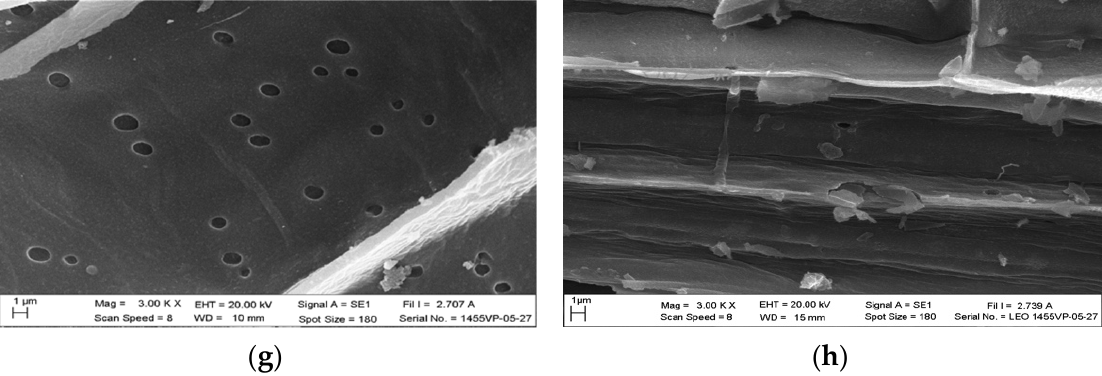
Figure 6. SEM morphologies acquired with a 3000 magnification of ( a ) activated carbon product pyrolyzed without hydrothermal at 350 °C; ( b ) activated carbon product made with 0% KMnO 4 pre-hydrothermal treatment and pyrolyzed at 300 °C; ( c ) activated carbon product made with 0% KMnO 4 pre-hydrothermal treatment and pyrolyzed at 350 °C; ( d ) activated carbon product made with 0% KMnO 4 pre-hydrothermal treatment and pyrolyzed at 400 °C; ( e ) activated carbon product made with 1% KMnO 4 pre-hydrothermal treatment and pyrolyzed at 350 °C; ( f ) activated carbon product made with 3% KMnO 4 treatment and pyrolyzed at 350 °C; ( g ) activated carbon product made with 5% KMnO 4 pre-hydrothermal treatment and pyrolyzed at 350 °C; ( h ) and activated carbon product made with 5% KMnO 4 pre-hydrothermal treatment and pyrolyzed at 400 °C.